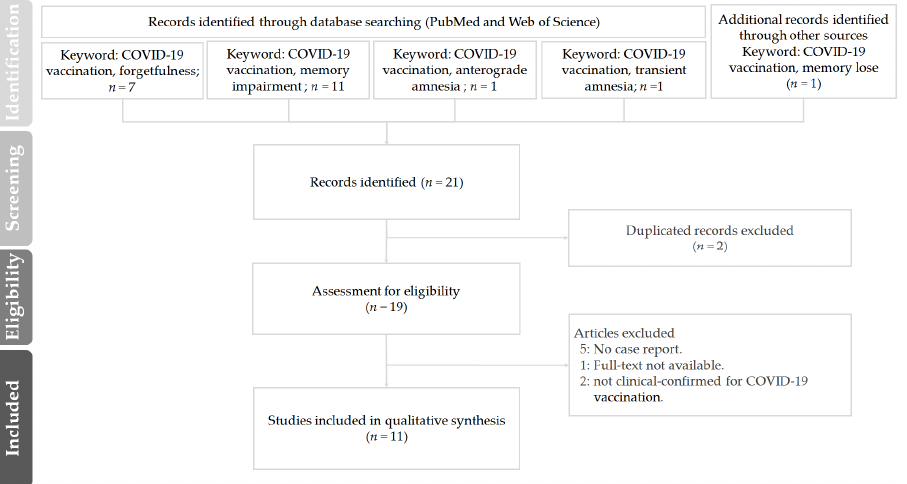
Figure 1. The PRISMA flow diagram of the literature review in this study on “forgetfulness or memory impairment or anterograde amnesia or transient amnesia or memory lose” on COVID-19 vaccination.